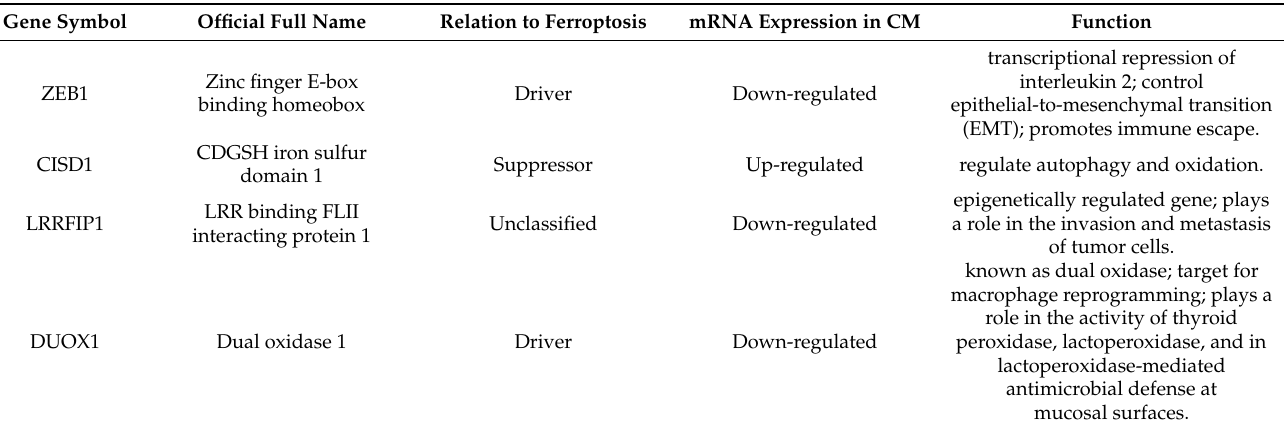
Table 2. Major biological characteristics of four genes corresponding to four DNA methylation sites in the FRG DNA methylation